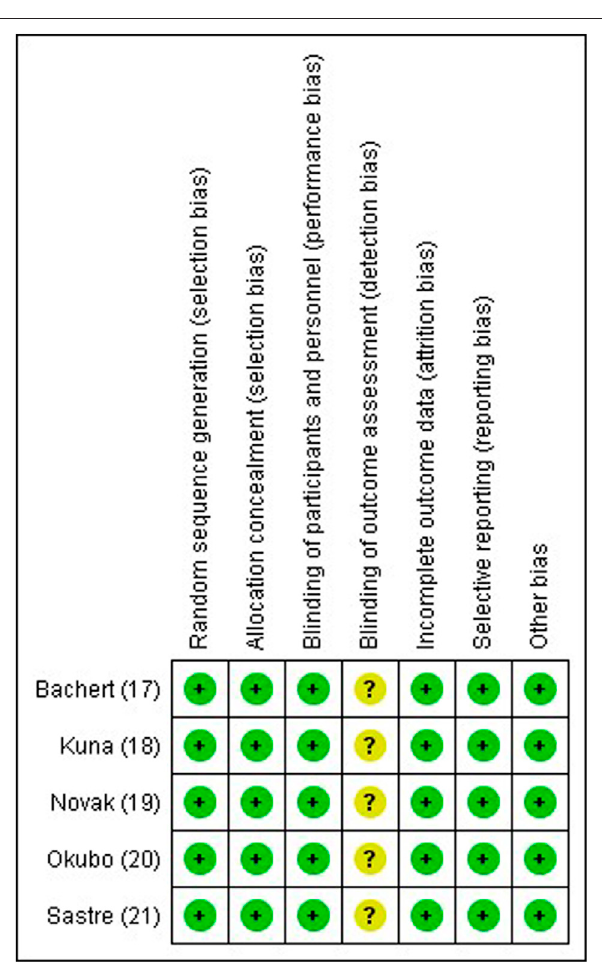
FIGURE 2 | Risk of bias